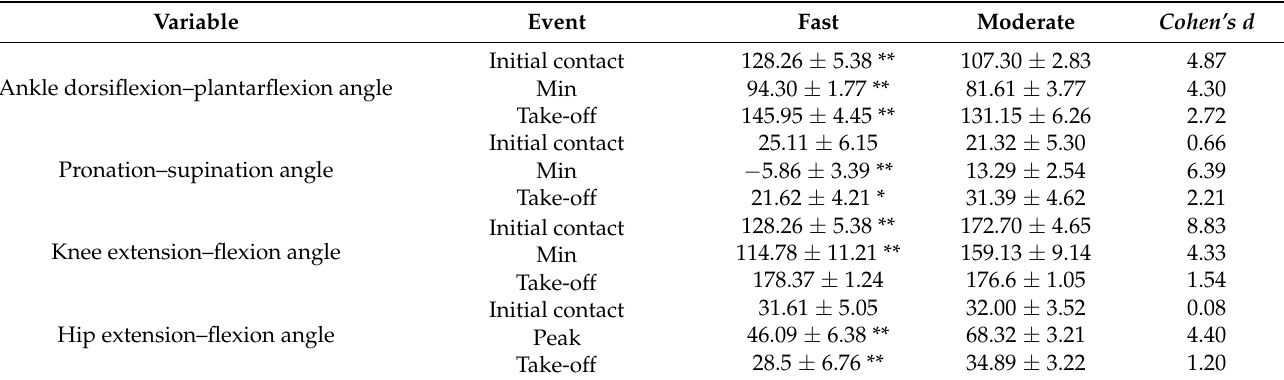
Figure 2. The curves of hip, knee and ankle joint angles across time. Table 1. The hip, knee and ankle joint angles (°) in each event.